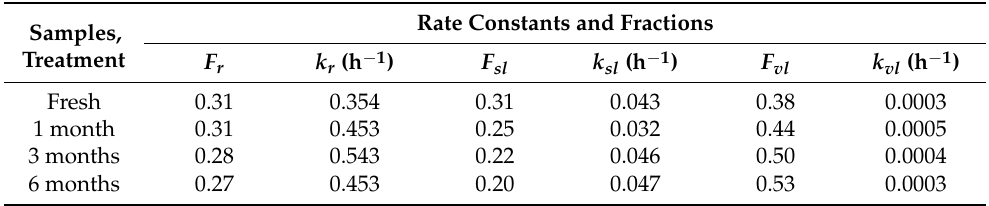
Table 3. Rate constants and fractions for the rapid, slow, and very-slow desorption of oxyfluorfen in unamended and biochar-amended soil samples predicted by consecutive Tenax extractions.